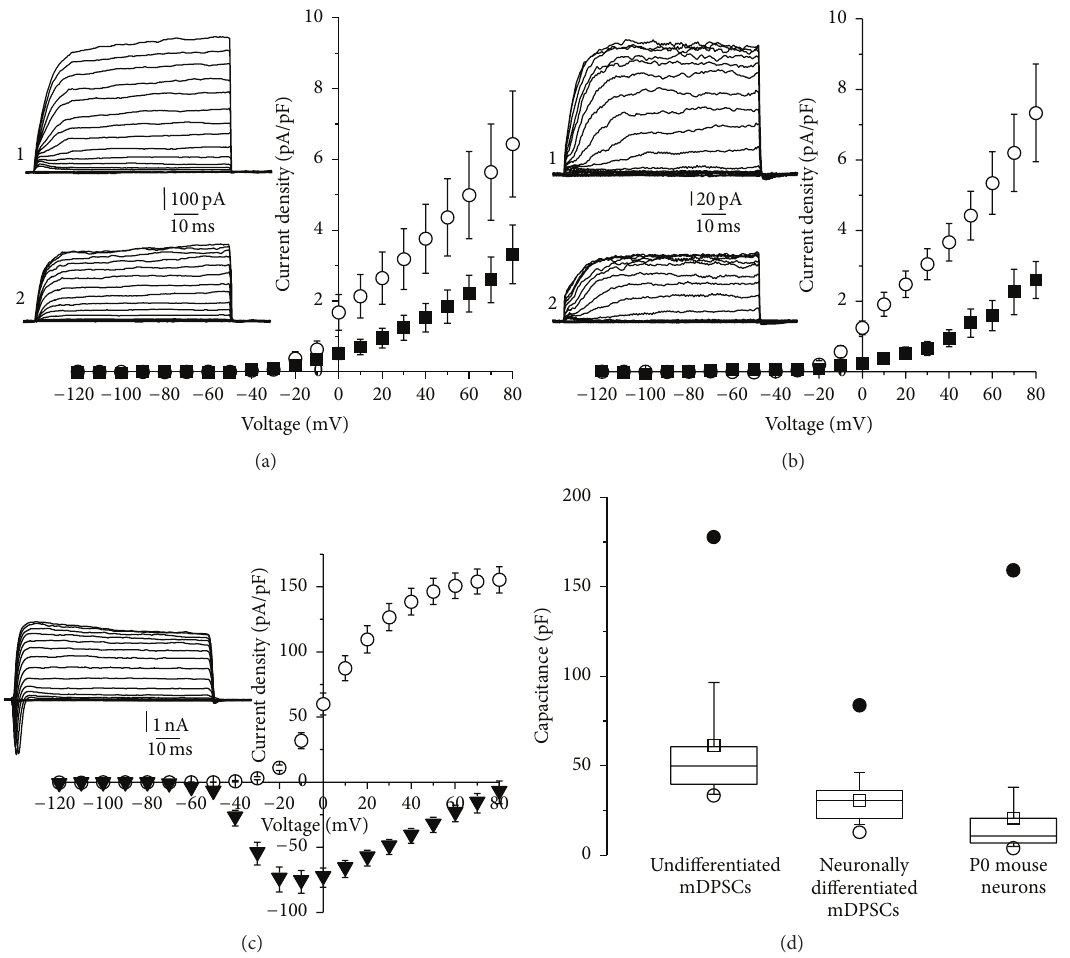
Figure 3: Neuronally differentiated high nestin-expressing mDPSCs show immature electrophysiology properties. Current density-voltage relationships of transmembrane K + currents of undifferentiated (a) and neuronally differentiated (b) high nestin-expressing mDPSCs (clone 2) in the absence ( I , inlet 1 illustrates exemplar trace of currents, 𝑛 = 14 and 17 cells, resp.) and presence of TEA (1mM) ( ◼ , inlet 2 illustrates exemplar trace of currents, 𝑛 = 9 for each differentiation condition). (c) Current density-voltage relationships of transmembrane K + current ( I ) and Na + currents ( 󳶃 ) of mSTM neurons ( 𝑛 = 23 cells). Inlet illustrates exemplar trace of currents. The mean ± SEM current densities at +80 mV of undifferentiated ( 6.4 ± 1.5 pA/pF) and neuronally differentiated mDPSCs ( 7.3 ± 1.4 pA/pF) showed a significant difference in comparison with primary cultured mSTM neurons ( 155.4 ± 10.1 pA/pF): 𝑝 < 3.0𝐸 − 13 and 𝑝 < 6.0𝐸 − 15 , respectively. (d) Comparison of capacitances of all three cell types. The mean values ± SEM ( ◻ ) of undifferentiated mDPSCs ( 62.0 ± 10.2 ) and neuronally differentiated high nestin-expressing mDPSCs ( 30.7 ± 4.0 ), as well as undifferentiated mDPSCs and P0 mSTM neurons ( 20.9 ± 6.6 ), were considered as significantly different: 𝑝 < 0.005 and 𝑝 < 0.002 , respectively. e and I are maximal and minimal values,